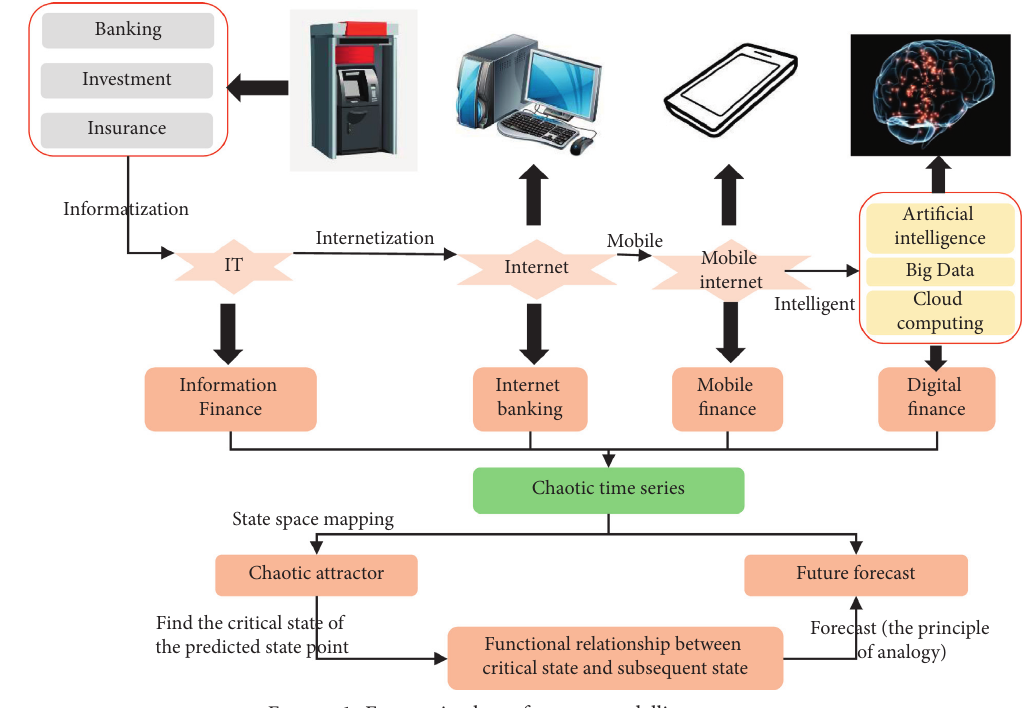
Figure 1: Economic chaos forecast modelling